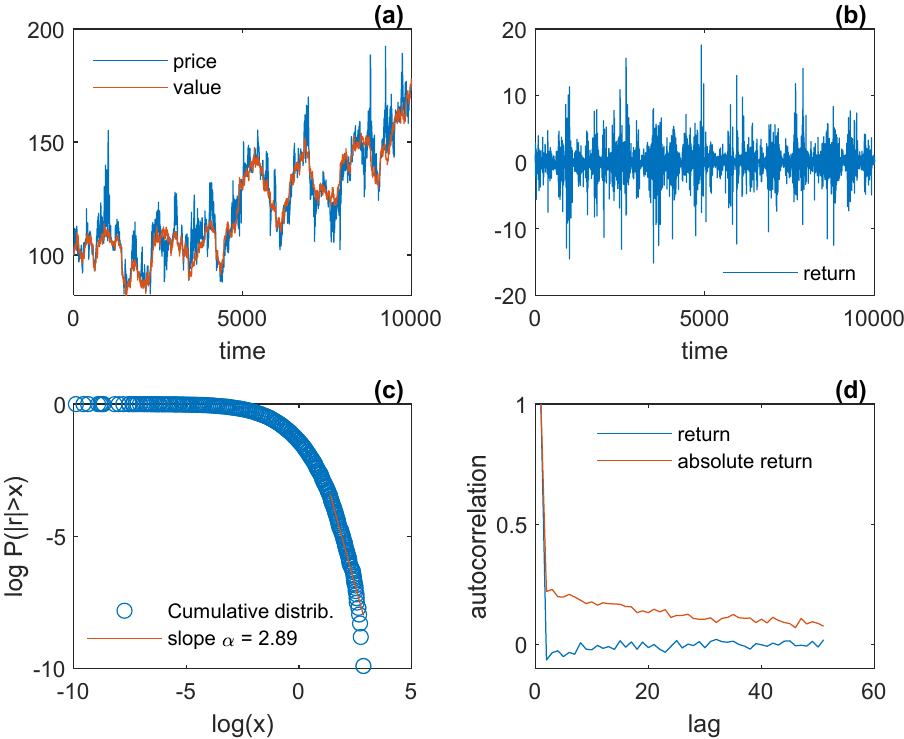
Figure 5. The general model illustrated: ( a ) price and value; ( b ) return; ( c ) tail; ( d ) autocorrelation function of return and absolute return.